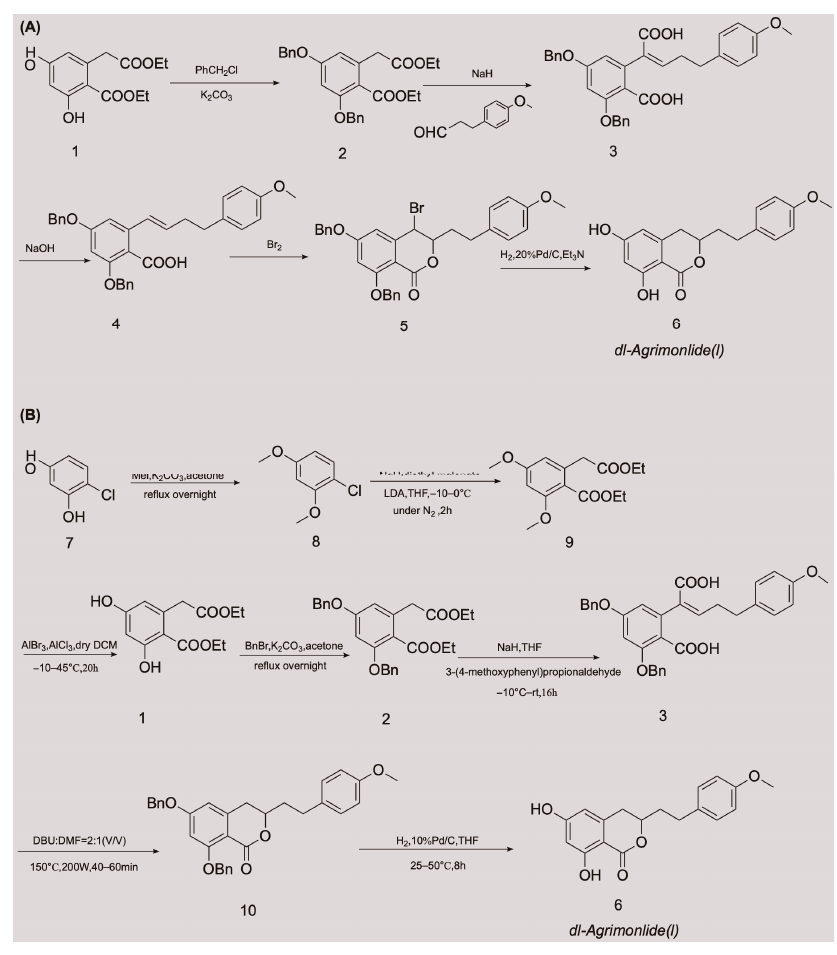
Figure 2. Chemical synthesis routes of AM [24 − 26].